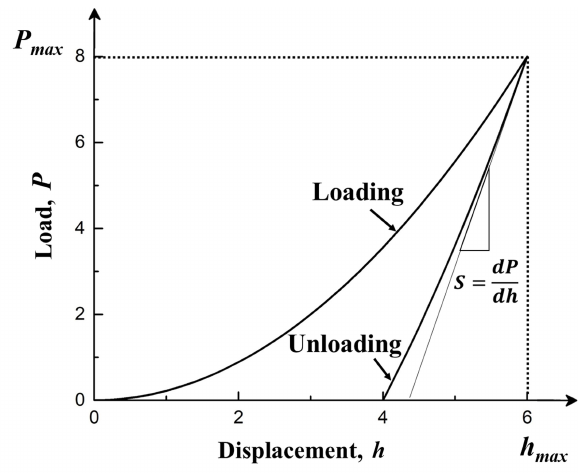
Figure 1: Typical load-displacement